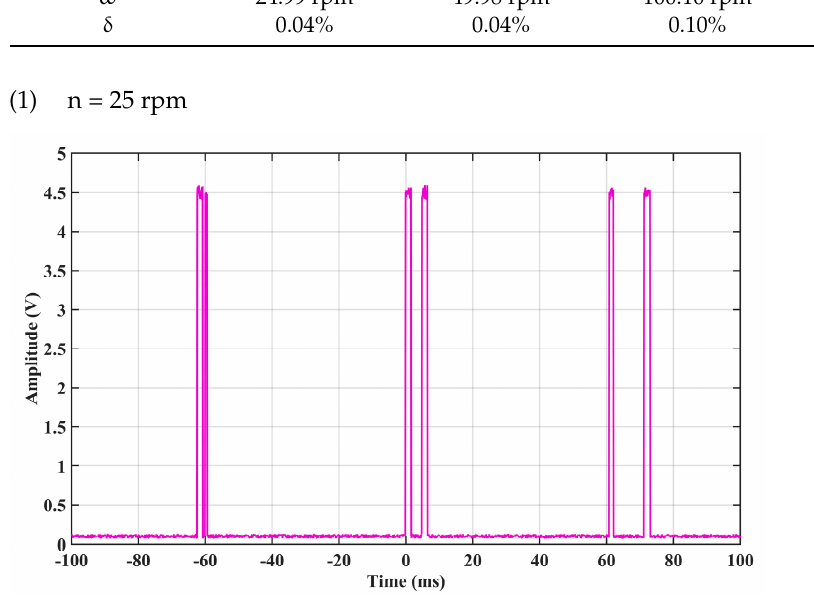
Figure 2. The 25 rpm oscilloscope waveform.